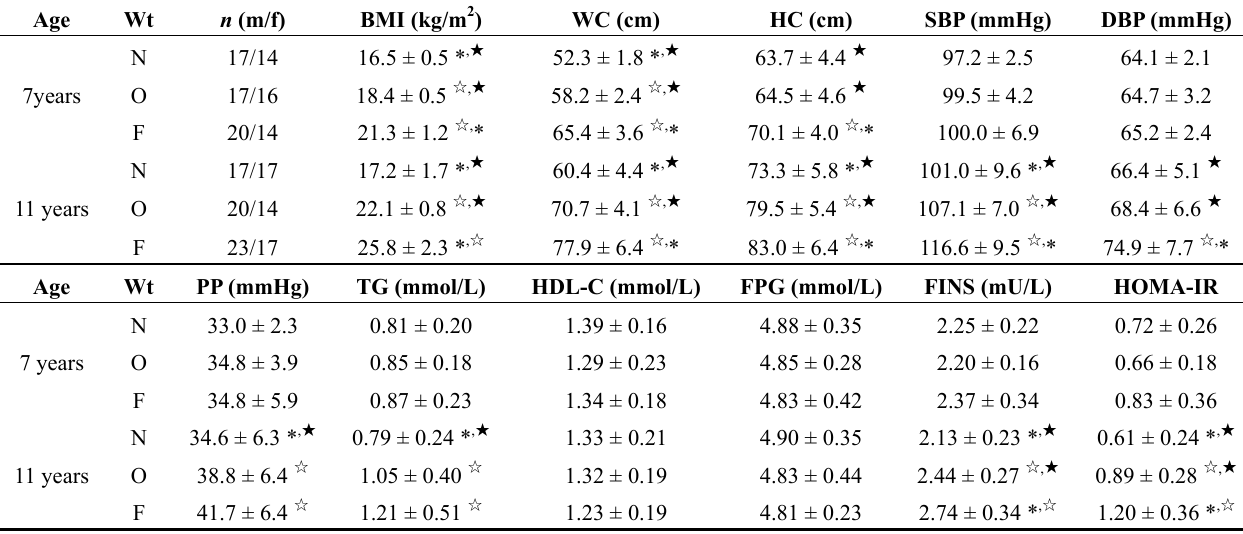
Table 2. Clinical features in different weight groups of 7- and 11-year old